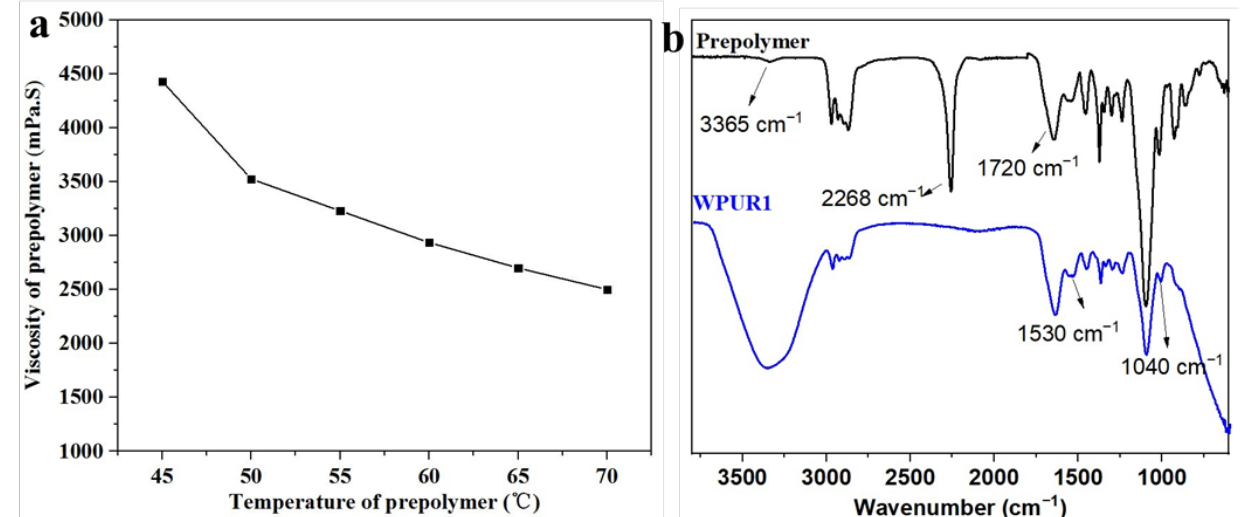
Figure 1. ( a ) Viscosity of prepolymer at different temperatures; ( b ) the Fourier transform infrared spectroscopy (FTIR) spectrum of prepolymer and WPUR1.